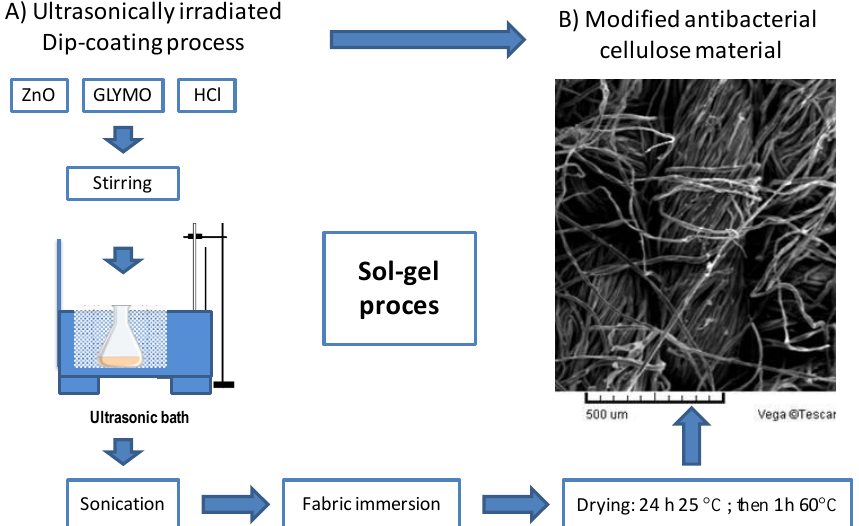
Figure 1. Schematic overview of ultrasonically irradiated dip-coating process with ( A ) diagram of sonicated sol–gel process and ( B ) the resulting SEM microphotograph recorded under a magnification of 80× on the modified antimicrobial cellulose material.